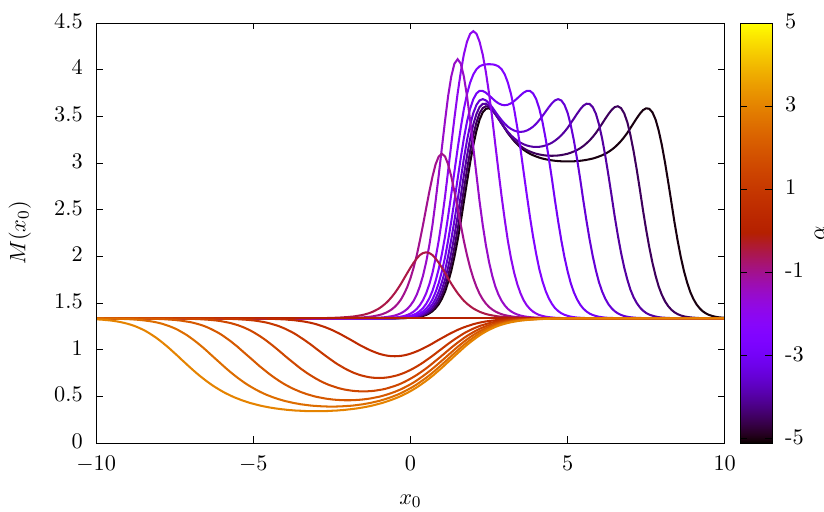
Figure 2 . Metric on the moduli space for the (cid:30) 4 BPS-impurity model (3.6) for di(cid:11)erent values of the impurity strength (cid:11)